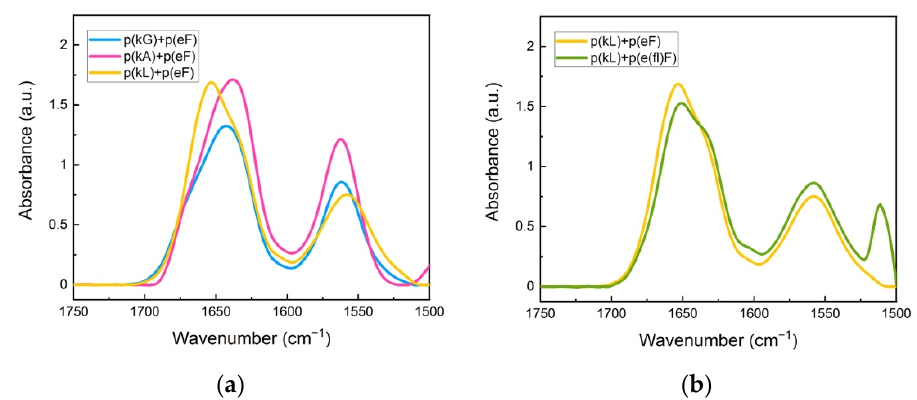
Figure 5. FTIR spectra of sequence pairs: ( a ) p(kG), p(kA), and p(L) with p(eF); ( b ) p(kL) sequence paired with p(eF), and p(e(fl)F). All sequence pairs show the characteristic random coil signal at around 1645 cm − 1 . The signal at 1564 cm − 1 is due to the sidechain stretching of the carbonyl group of glutamic acid. The peak at 1510 cm − 1 and also a low intensity signal at around 1603 cm − 1 are indicative of carbon-carbon stretching vibration in the aromatic ring of fluoro-phenylalanine.